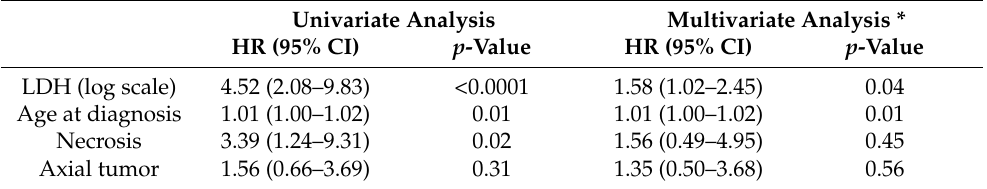
Table 2. Multivariate survival model with LDH as a continuous predictor (per known prognostic factor).